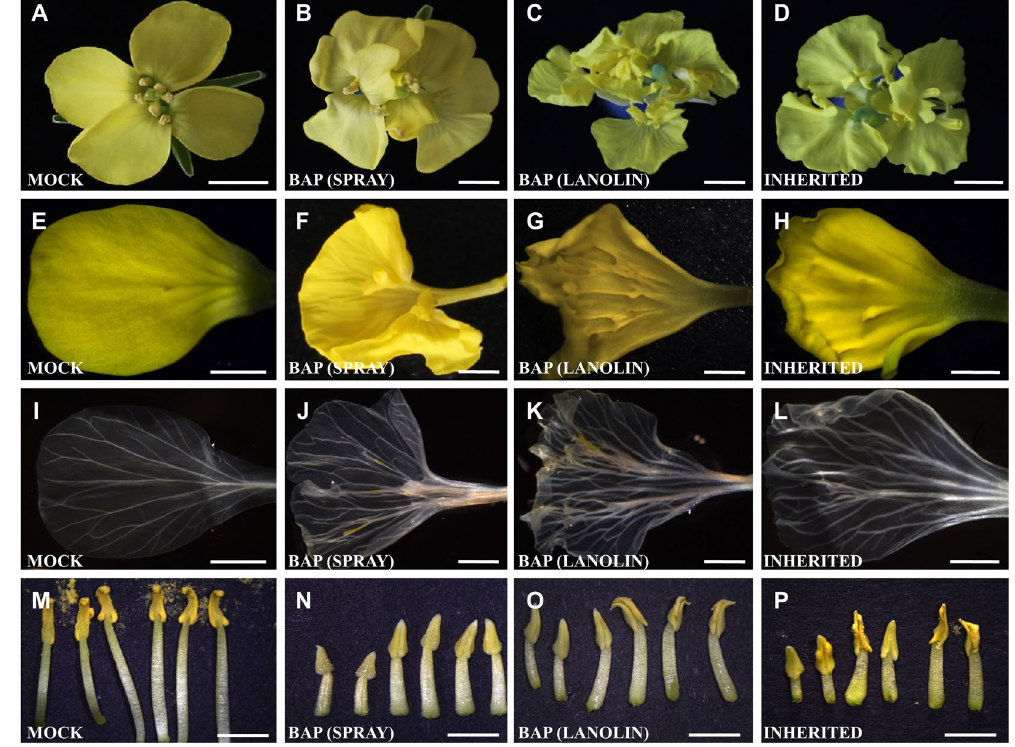
Figure 2. Phenotypes caused by exogenous BAP application in Brassica napus flower. ( A , E , I , M ) Mock-treated wild type flowers. ( B , F , J , N ) BAP-treated flowers by spraying. ( C , G , K , O ) BAP-treated flowers by lanoline. ( D , H , L , P ) Offspring of BAP-treated flowers. Scale bars: ( A – D ) 5 mm; ( E – L ) 2 mm; ( M – P ) 3.5